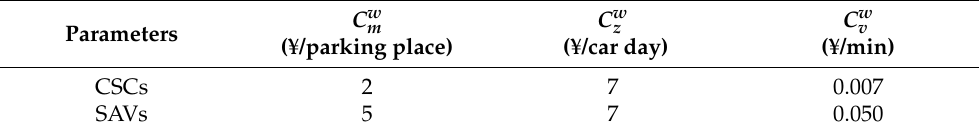
Table 5. Parameters for the case studies.